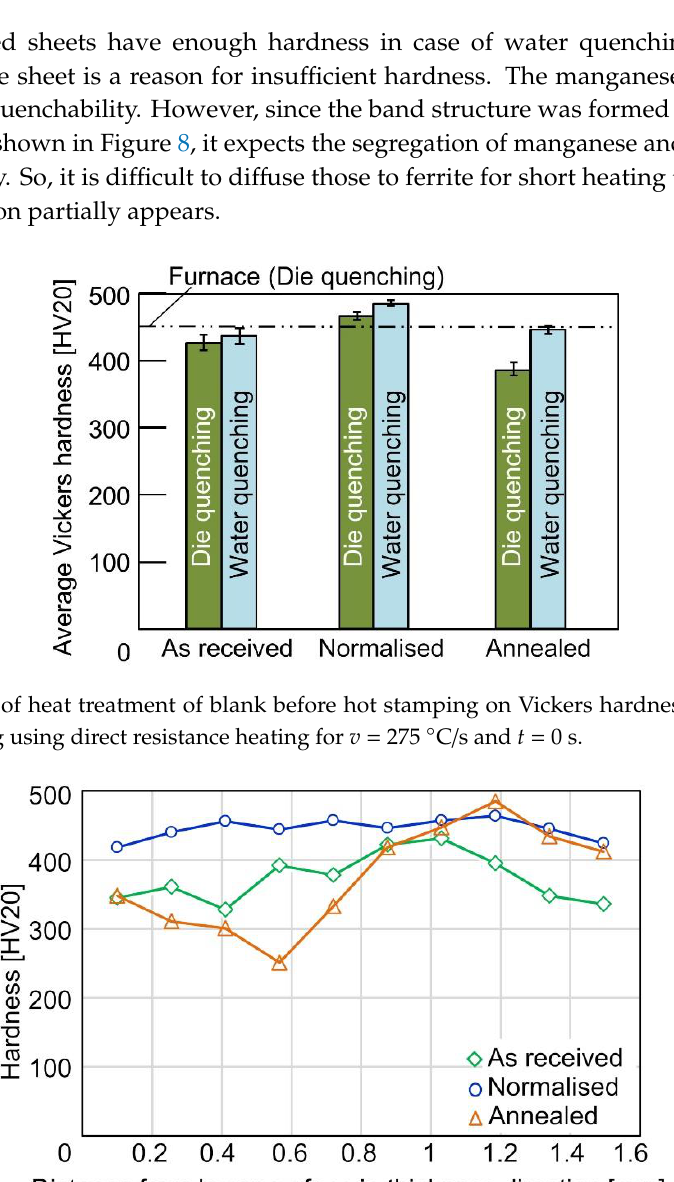
Figure 11. Effect of average grain size of blank on Vickers hardness after die- and water-quenching using direct resistance heating for v = 275 °C/s and t = 0 s. The microstructures of the die- and water-quenched sheets from as-received, normalised and annealed sheets for v = 275 °C/s and t = 0 s are shown in Figure 12. On the results of die quenching, ferrite is observed for as-received and annealed sheets. In particular, ferrite forms a thick layer in the result of the annealed sheet, corresponding to the microstructure shown in Figure 8c. As a result of